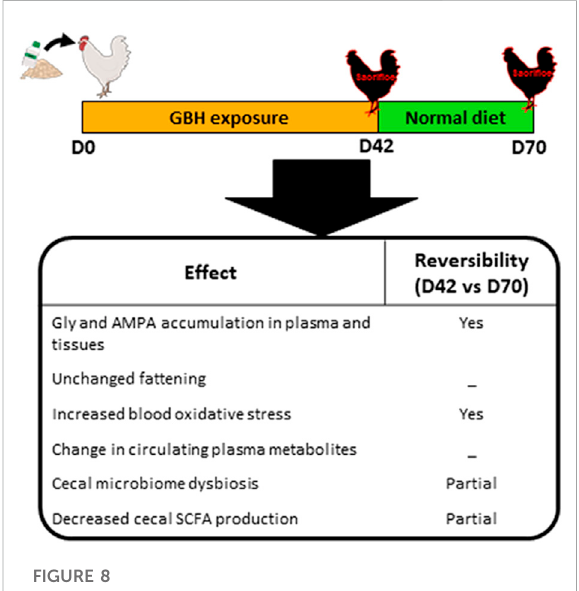
FIGURE 8 Schematic representation of effects of dietary GBH exposure in hens and their potential reversibility on glyphosate and AMPA accumulation in plasma and tissues, fattening, plasma oxidative stress, plasma metabolites, cecal microbiome dysbiosis and cecal SCFA